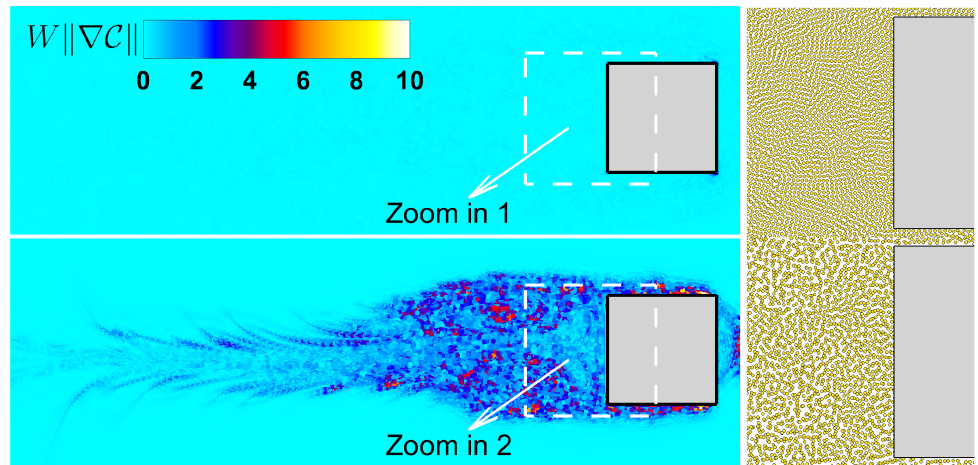
Figure 10. The quality of particle distribution with (top panel) and without (bottom panel) PST. W (cid:107)∇C(cid:107) is closer to zero when the particle distribution is more uniform. For more details regarding the simulation configurations, the readers can refer to